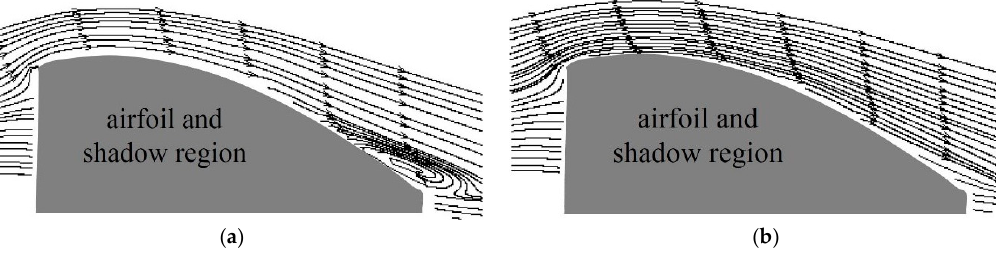
Figure 34. Mean-flow streamlines for Re = 64,200 and α = 13.8 degrees. ( a ) Uncontrolled flow and ( b ) plasma actuator at 2% chord with F + = 0.88. (Reprinted from [29]).